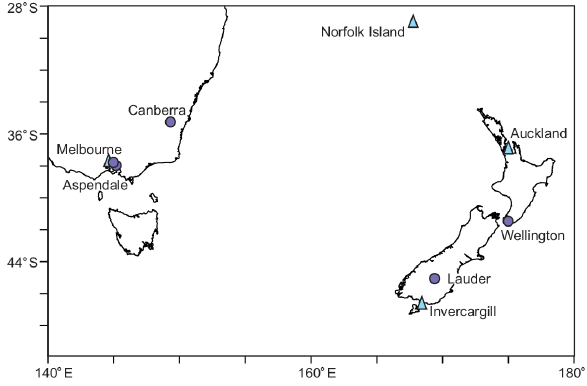
Figure 1. Map of the stations used (circles: ozone; triangles: upper air). Table 1. Wavelengths (nm) and absorption and scattering coeffi- cients for different wavelength pairs for standard settings (Komhyr et al., 1993; Komhyr and Evans, 2008) and for the instrument in